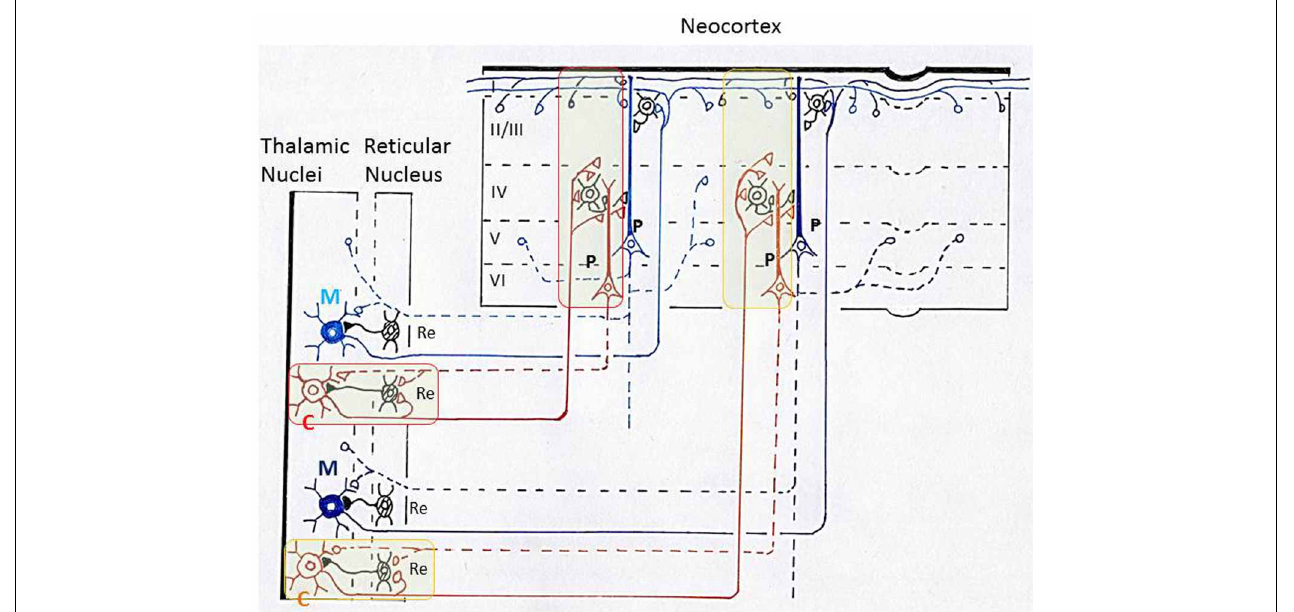
FIGURE 7 | Schematic diagram illustrating thalamo-cortico-thalamic networks and the “matrix and core theory” of Jones. This diagram is based on Llinas et al. (1998) and Jones (2001). Core neurons (C) in the thalamus form specificity-projecting circuits (shown by brown lines and surrounded by red or yellow lines) that involve specific cortico-thalamic connections from layer VI pyramidal cells. Matrix neurons (M) in the thalamus give rise to non-specific binding circuits (shown by blue lines) that involve